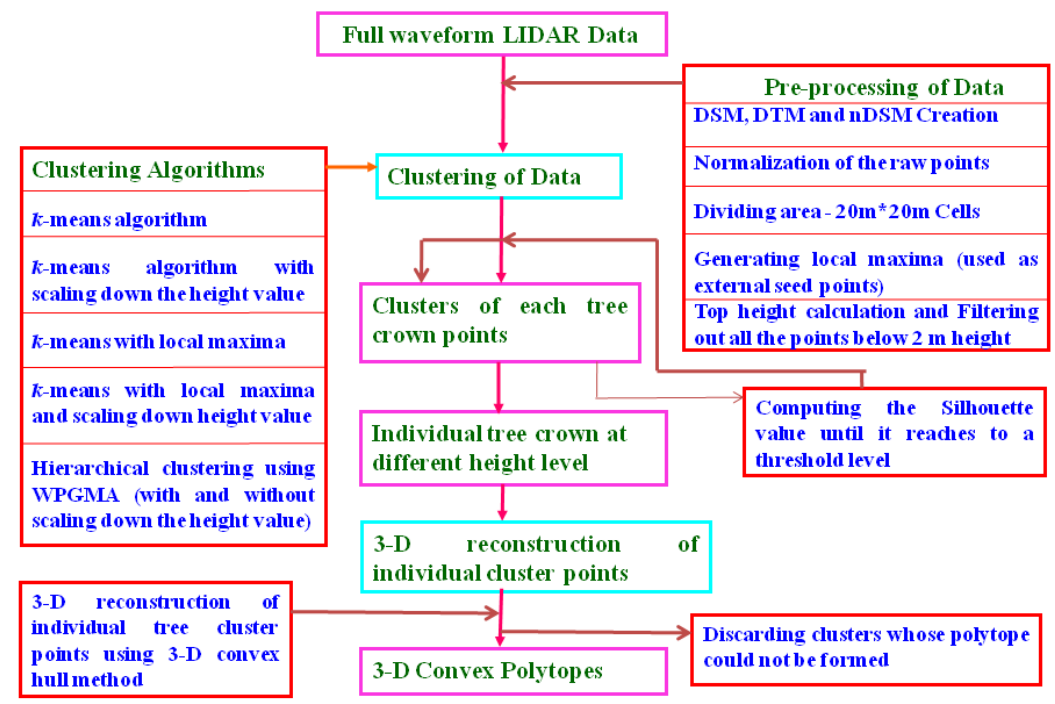
Figure 2. Methodology flow